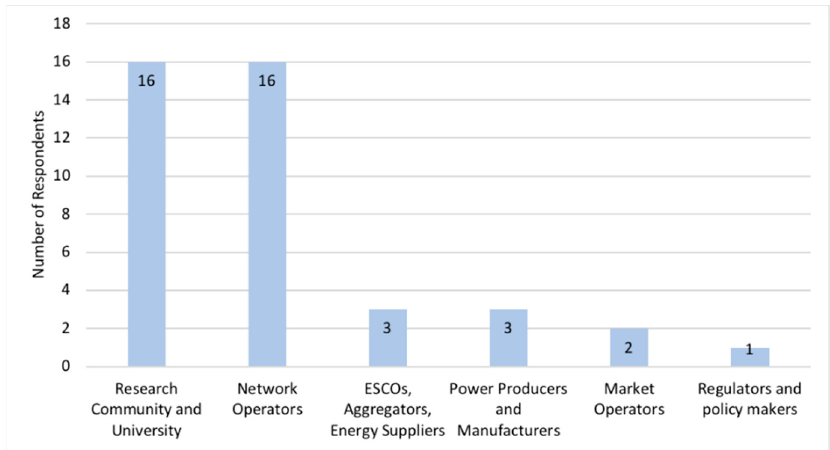
Figure 6. Distribution of survey participants by the power sector group.